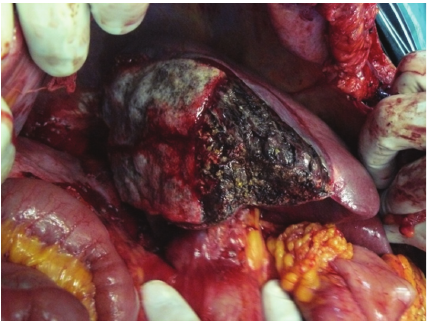
Figure 4: Coagulated and topical hemostatic covered cut surface of the